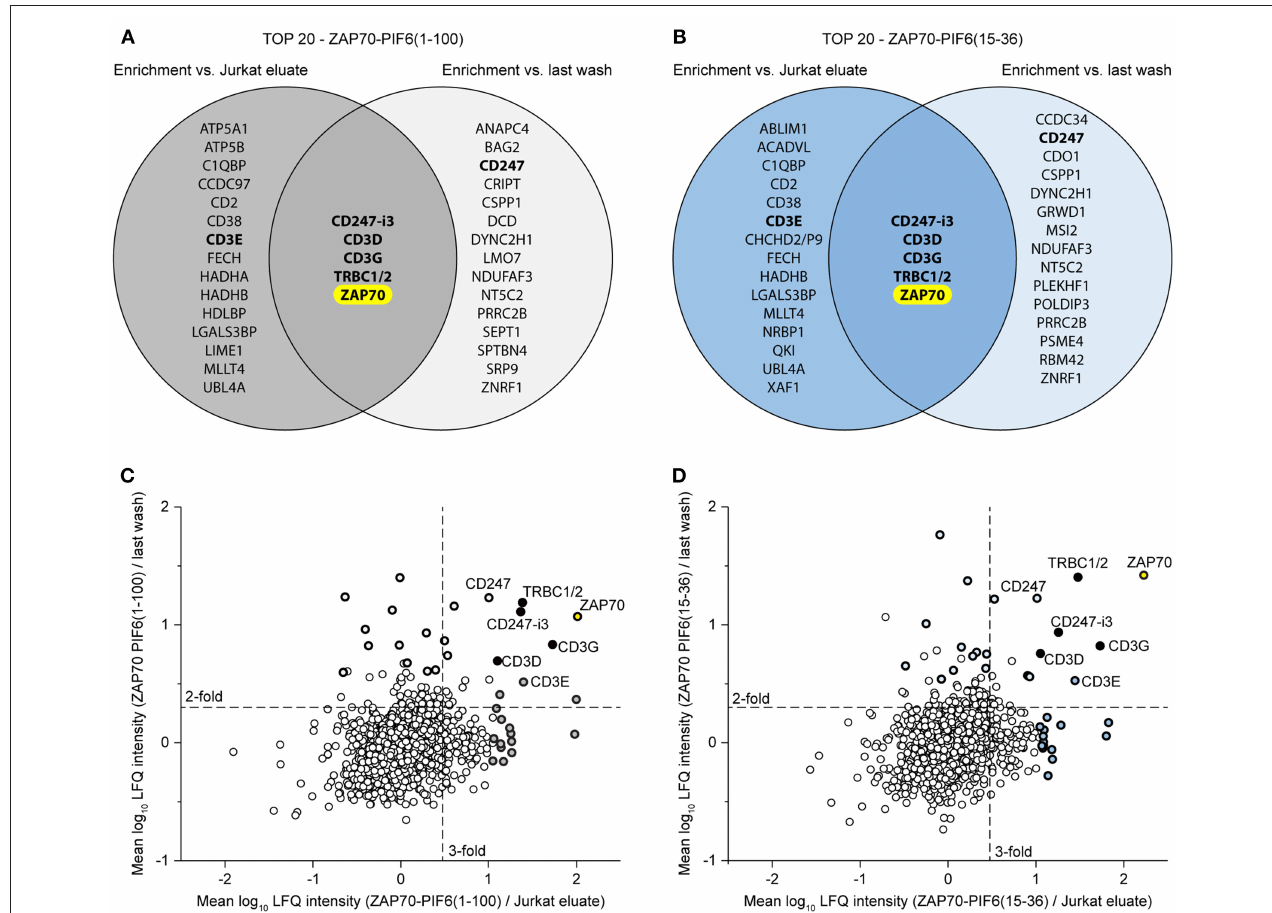
FIGURE 6 | Usage of two controls to confine the data to the most relevant interaction partners of the POI ZAP70. (A,B) Comparison of the 20 best hits ( p < 0.05, sorted on protein enrichment) enriched in the eluates of the ZAP70-PIF6(1-100) (A) /ZAP70-PIF6(15-36) (B) cell line vs. the eluates from the Jurkat cell line or the flow-throughs of the last washing step. Known interaction partners of ZAP70 are written in bold. (C,D) Enrichment of proteins identified in the ZAP70-PIF6(1-100) (C) /ZAP70-PIF6(15-36) (D) eluates vs. the Jurkat eluates (x-axis) plotted against the enrichment of proteins in the ZAP70-PIF6(1-100) (C) /ZAP70-PIF6(15-36) (D) eluates vs. the corresponding flow-throughs of the last washing step (y-axis). The enrichment for each protein is shown as the mean log 10 ratio of the label-free quantification (LFQ) intensities (3 biological replicates) of the compared samples. Known double-positive interaction partners of ZAP70 identified within the TOP 20 hits in (A) / (B) are highlighted in black and the names are indicated; the remaining hits of the TOP 20 are highlighted as bold black circles filled with the color corresponding to the group color used in the VENN diagram in (A) / (B) . The POI ZAP70 is highlighted in yellow. Dashed lines represent a ratio cut-off corresponding to a 3-fold or 2-fold enrichment. CHCHD2/P9, CHCHD2, CHCHD2P9; CD247-i3, CD247 isoform 3; TRBC1/2, TRBC1,